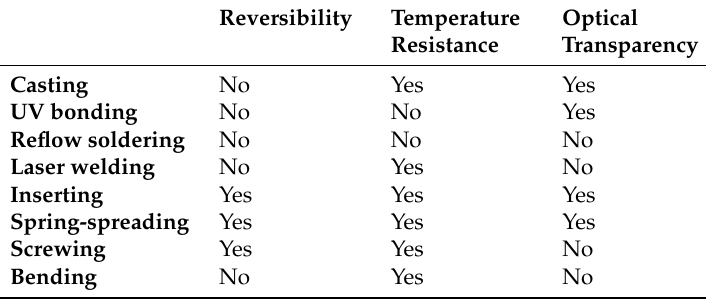
Table 6. Constraint matrix for the process